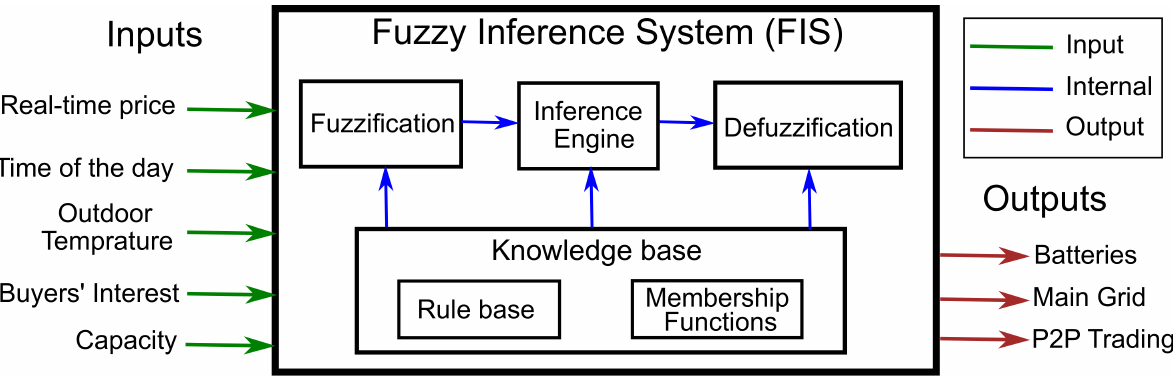
Figure 3. Multi-Input and Multi-Output (MIMO) fuzzy inference